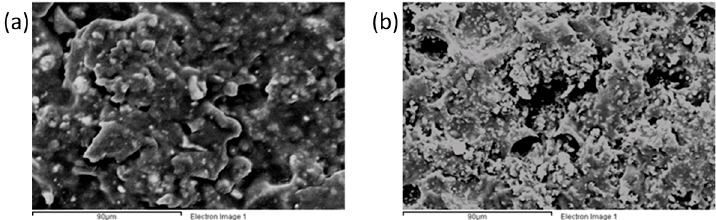
Figure 7. Scanning electron microscope (SEM) images of stabilized sample-composite material 50% wt ( a ) and CaCO 3 composite material 50% wt ( b ) at magnification 2000 × .